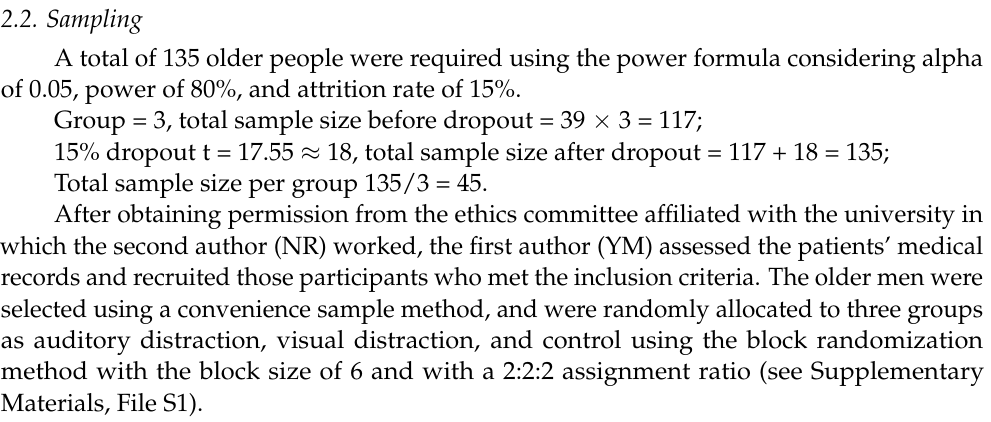
Figure 1. Process of the study according to the Consort flow diagram (2010).